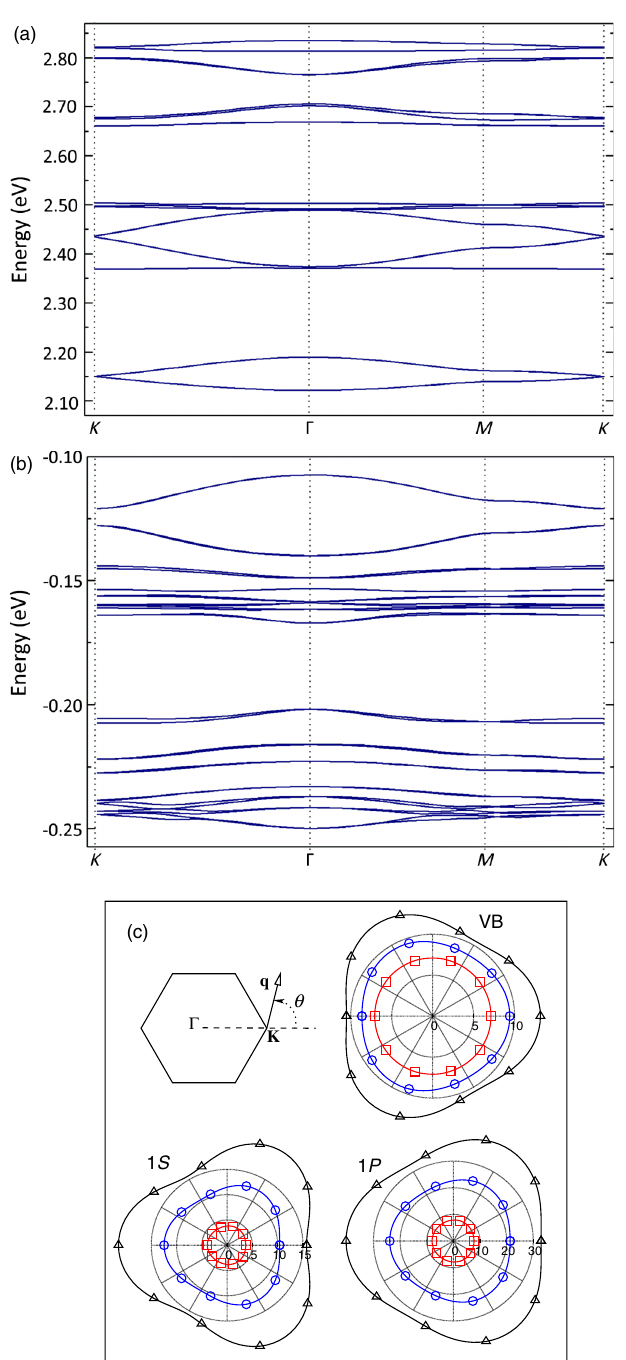
FIG. 2 (color online). (a) Lowest conductionbands and (b) high- est valence bands of a graphene-type honeycomb lattice of truncated nanocubes of CdSe (body diagonal of 4.30 nm). The zero of energy corresponds to the top of the valence band of bulk CdSe.(c)Energysplittings(meV) betweenthe twohighestvalence bands(VBs),betweenthetwo 1 S Diracconductionbands( 1 S ),and between the two 1 P Dirac conduction bands ( 1 P ) calculated at K þ q and plotted using polar coordinates, i.e., energy versus the angle between K and q . (The squares and red curve correspond to j q j ¼ 0 . 05 j K j , the circles and blue curve to j q j¼ 0 . 15 j K j , and the triangles and black curve to j q j¼ 0 . 25 j K j